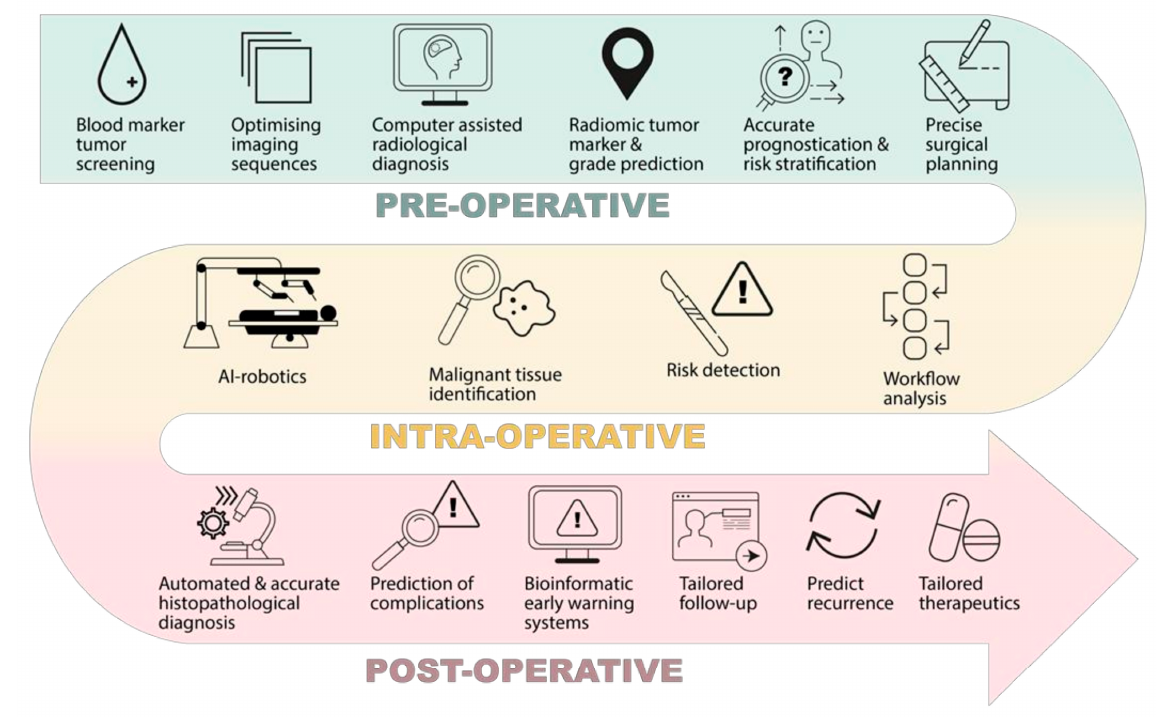
Figure 2. Examples of AI potential applications in clinical care. Reproduced from